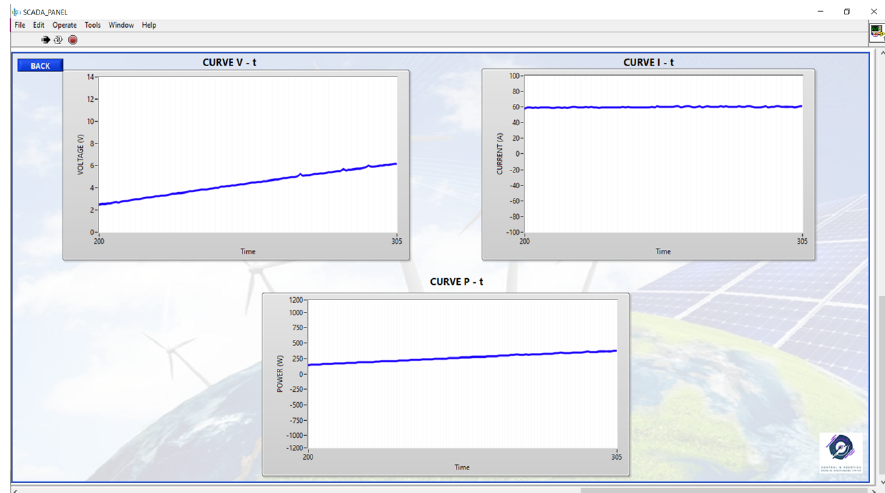
Figure 13. Second window in user interface. Charging and discharging chart of the supercapacitor power bank.